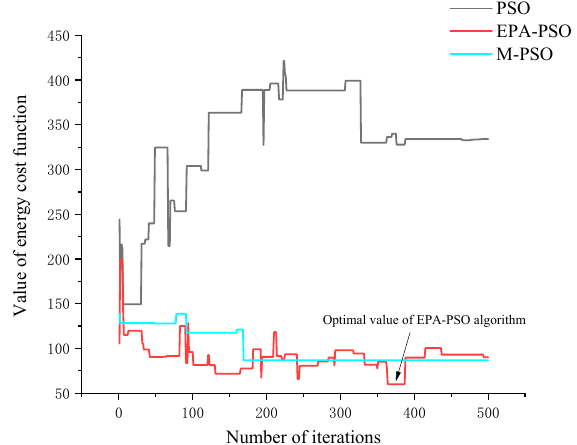
Figure 15. Numerical comparison of energy cost functions after 500 iterations.